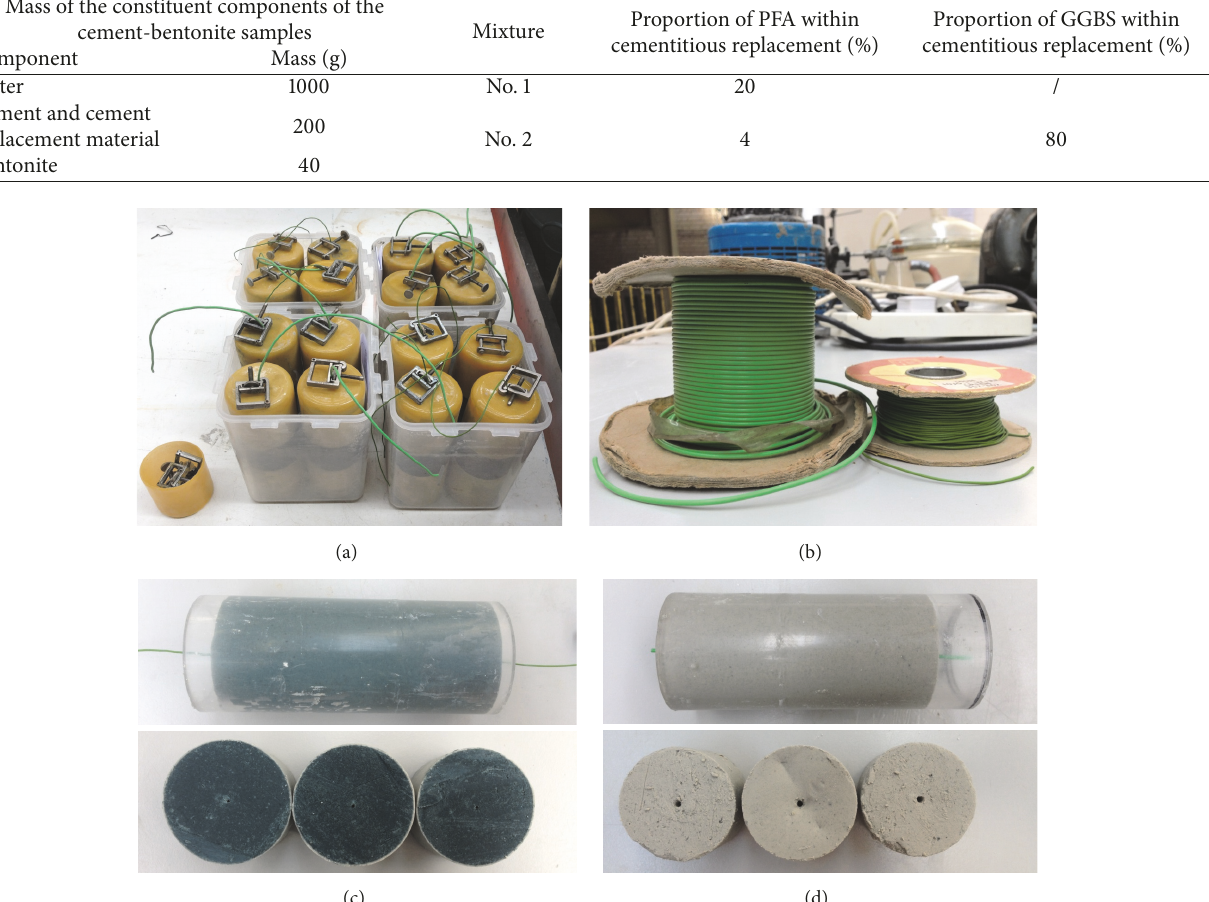
Figure 2: Illustration of the handling of samples; (a) decanted slurry curing within moulds stored in a constant temperature room at a temperature of 5 ∘ C; (b) two sizes of wires were used to create initial holes; (c) CB-GGBS sample with 1 mm initial hole; (d) CB-PFA sample with 2 mm initial